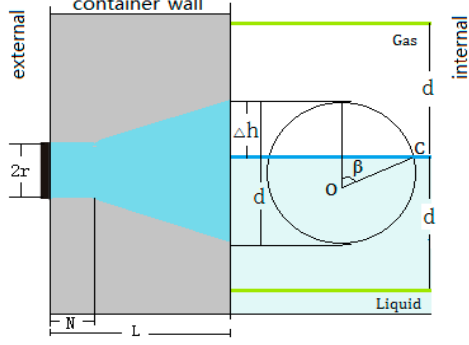
Figure 3. The two parts of the energy circle divided by the liquid level.